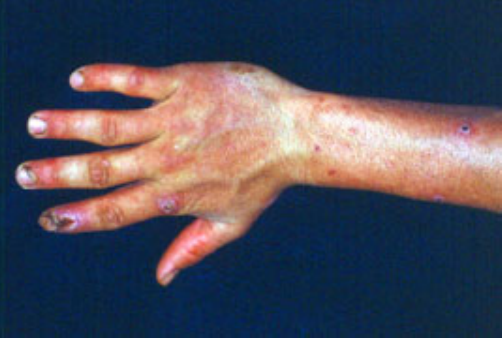
Figure 6: Multiple